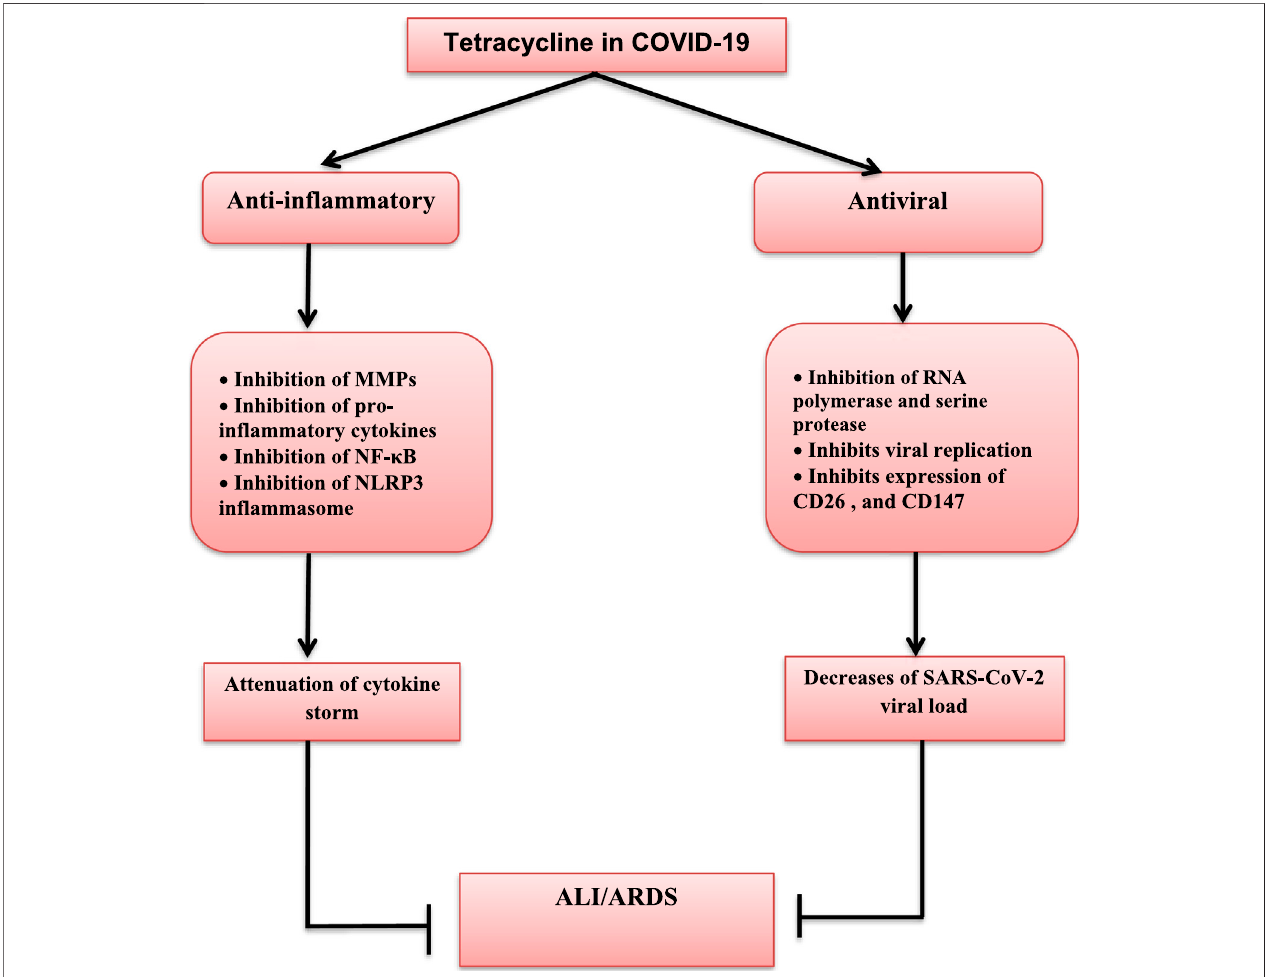
FIGURE 1 | Pleiotropic effects of tetracycline in SARS-CoV-2 infection. Tetracycline has antiviral and anti-in fl ammatory effects. Antiviral effects of tetracycline are through inhibition of RNA-polymerase and serine protease dependent viral replications, and inhibition of the expression of CD26 and CD147, which are regarded as entry-point for SARS-CoV-2 withsubsequent reduction in viral load. Anti-in fl ammatoryeffectsof tetracycline are through inhibition ofmatrix metalloproteinases (MMPs), nuclear factor kappa B (NF- κ B), Nod-like receptor pyrin 3 (NLRP3) in fl ammasome, and release of pro-in fl ammatory cytokines with subsequent attenuation of cytokine storm development. Taken together, both anti-in fl ammatory and antiviral effects of tetracycline inhibit development of acute lung injury (ALI) and acute respiratory distress syndrome (ARDS) in COVID-19.